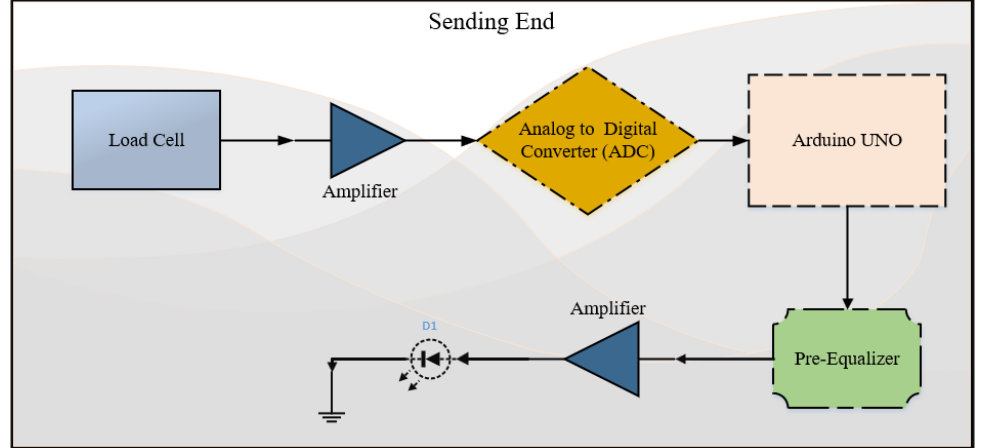
Figure 3. Proposed VLC tele-weight Sending End.